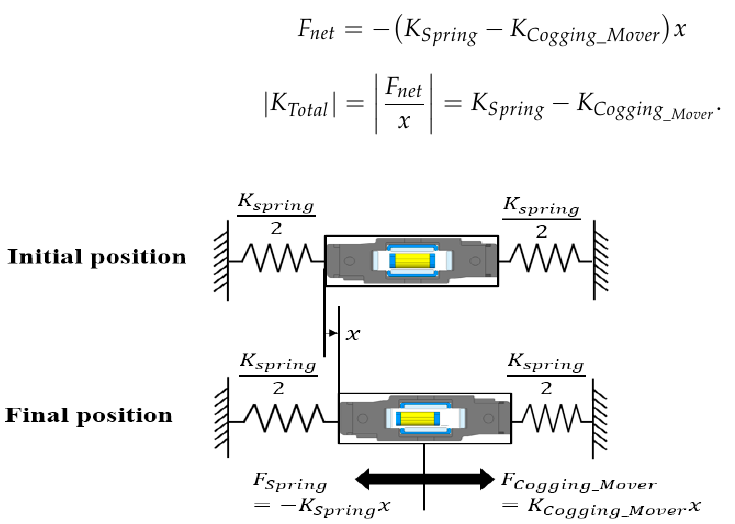
Figure 11. Initial position and final position of